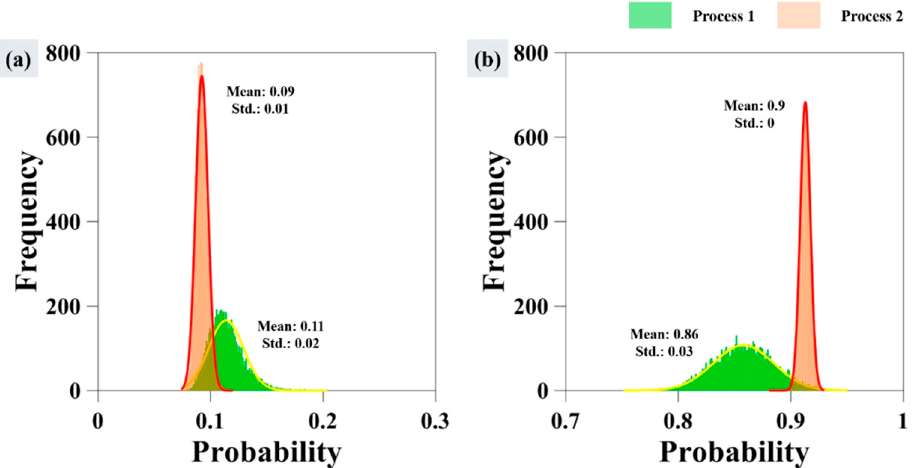
Figure 11. Histogram of sites B and C. ( a ) Histogram of results of Process 1 and Process 2 at oil-free surface; ( b ) Histogram of results of Process 1 and Process 2 at oil-covered surface.